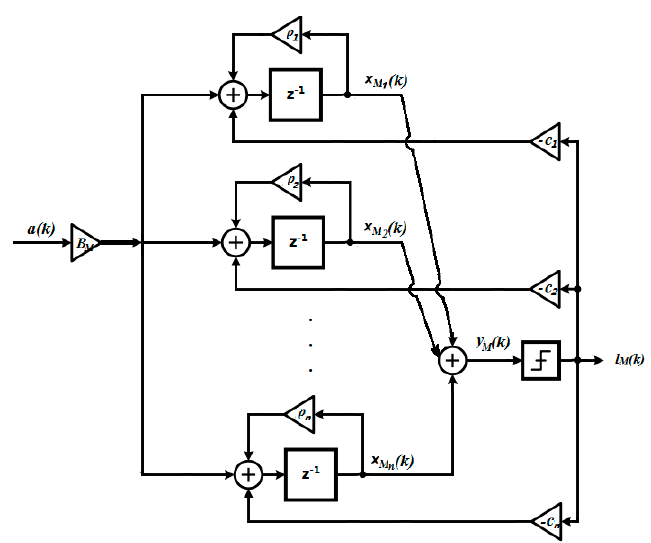
Figure 5. N th order Δ∑ modulator with parallel state variables (Thick lines denote vector routing). In Figure 5, 𝜌 (cid:2869) , 𝜌 (cid:2870) … 𝜌 (cid:3041) are the eigenvalues of 𝐴 (cid:3014) . It is worth noting that the inclusion of linear feedback paths other than the resonators results in a diagonal canonical form of 𝐴 (cid:3014) . It is possible to